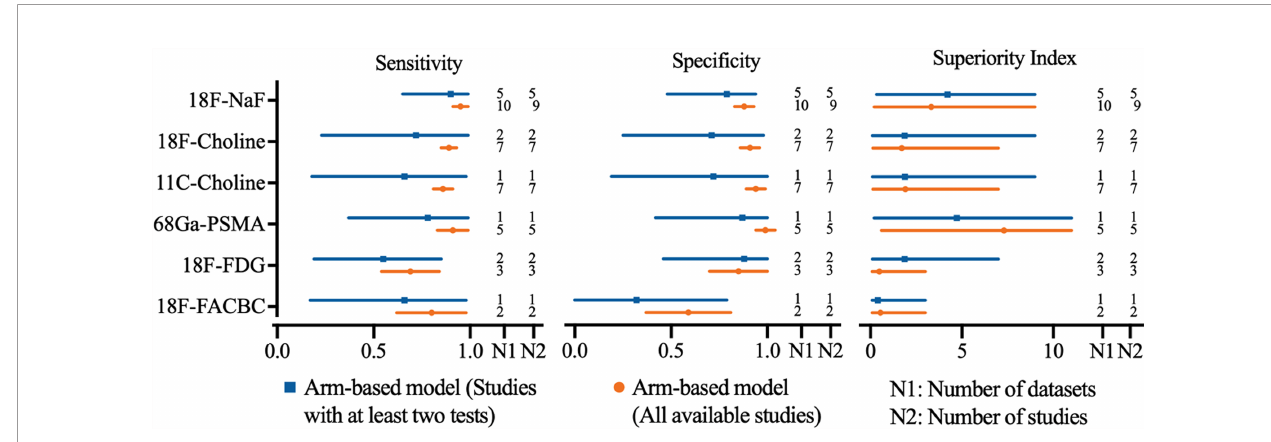
FIGURE 2 | Network meta-analysis results including sensitivity, speci fi city, and superiority index values of PET/CT with six commonly used tracers for the detection of bone metastasis in prostate cancer patients. Sensitivity, speci fi city, and superiority index are reported as mean (range) unless otherwise indicated. PET/CT, positron emission tomography/computed tomography; NaF, sodium fl uoride; PSMA, prostate membrane antigen; FDG, fl udeoxyglucose; FACBC, fl